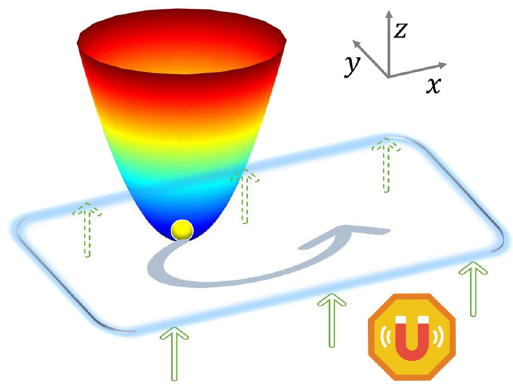
Fig. 1 Schematic of a driven quantum particle under a magnetic fi eld. A charged particle is dragged by a harmonic potential, whose minimum position follows an external force. The gray arrow illustrates a moving trajectory of the potential well on a two-dimensional plane. A uniform magnetic fi eld (green arrow) applies to the positive- z direction, which alters the free energy change in the quantum